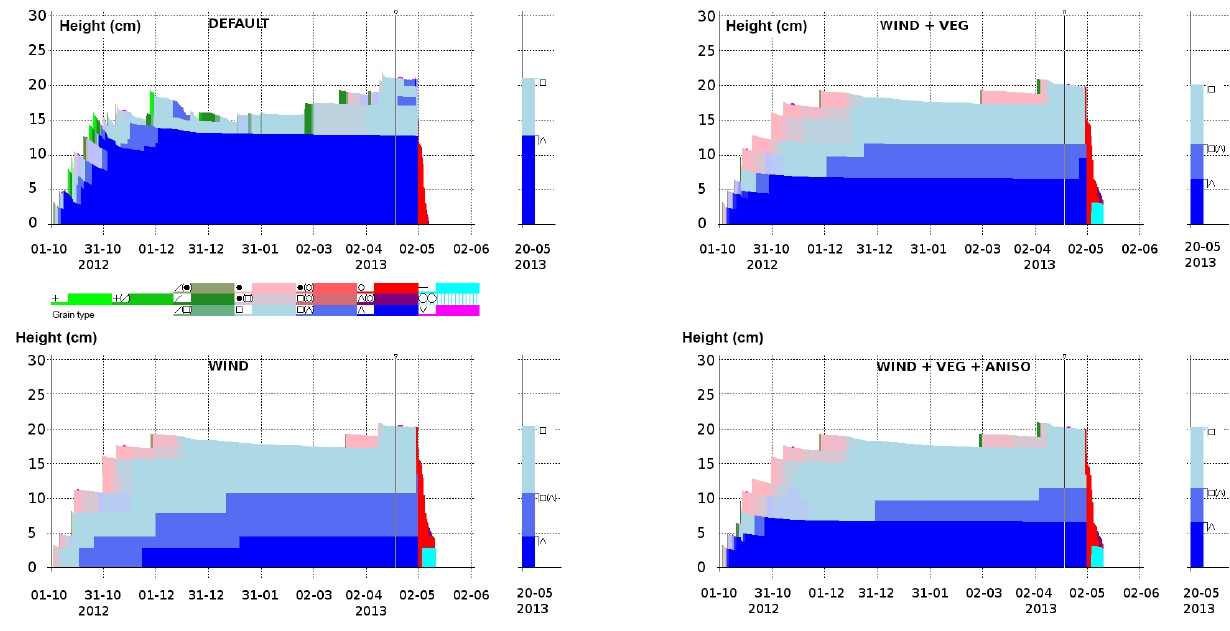
Figure 6. SNOWPACK grain shapes in the four simulation set-ups. The colour code was complemented with grain shape symbols after Fierz et al. (2009) for the 20 May 2013 profile (representative of the time of the snow campaign).